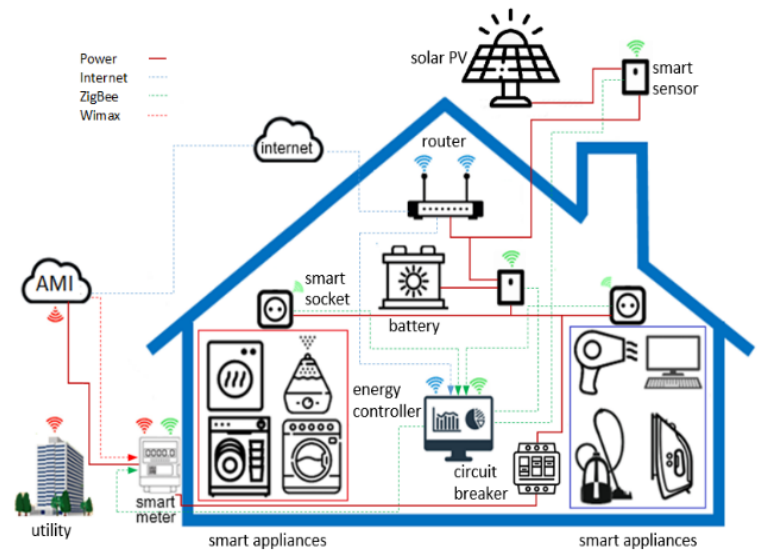
Figure 1. Basic architecture of the HEMS with a wireless home area